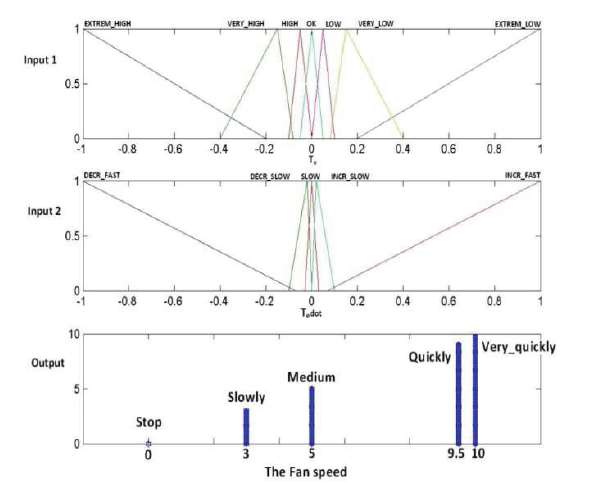
Fig. 2. The Global structure of the classical Fuzzy Logic Controller used in the